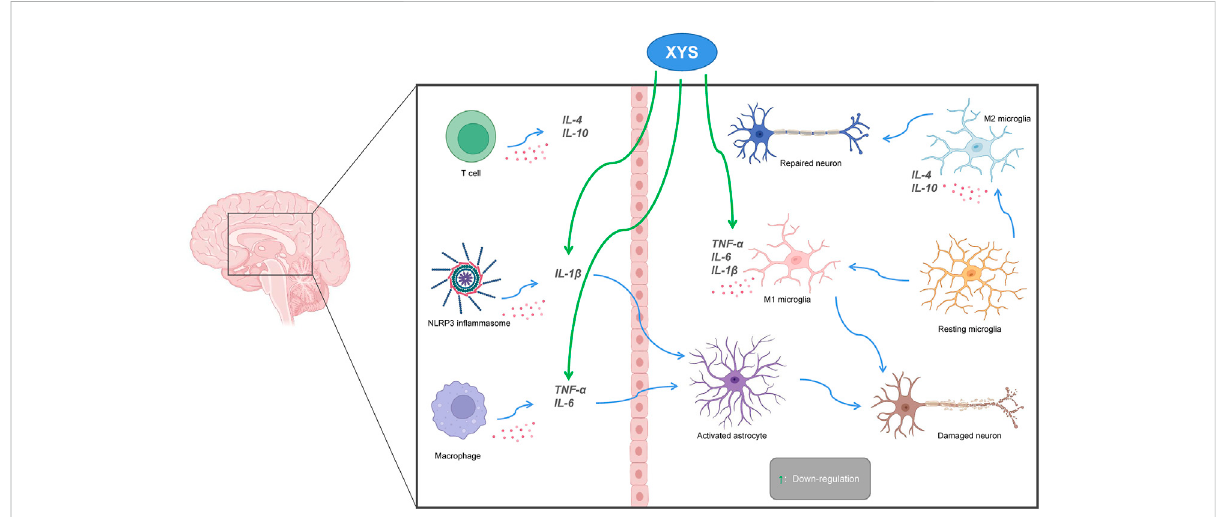
FIGURE 5 The relationship between Xiaoyaosan, depression and neuroin fl ammation. Pro-in fl ammatory cytokines (IL 1 β , IL6, TNF- α ) activate astrocytes, leadingtoneuronaldestruction.Down-regulationofpro-in fl ammatorycytokinesbyXiaoyaosaninhibitsactivationofastrocytesandavoidsneuronal